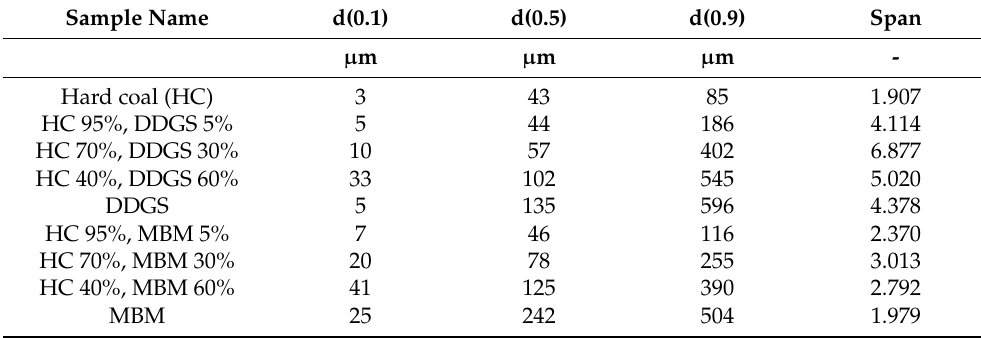
Table 1. Size properties of the tested samples.